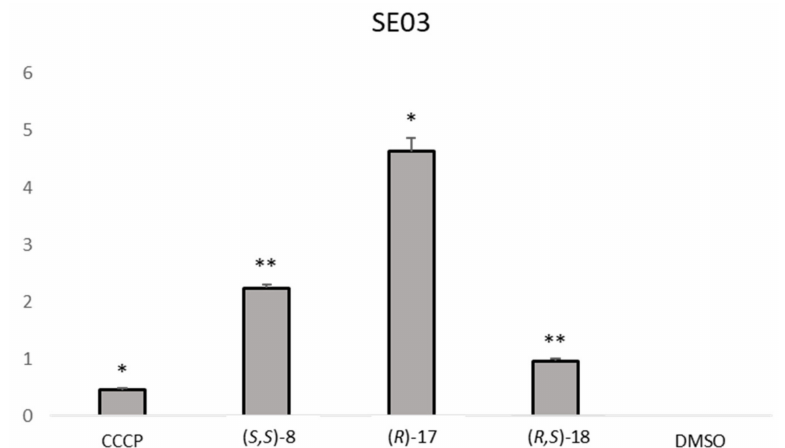
Figure 2. Comparison of the RFI of different compounds to those of the positive controls [ S. aureus 272123 ( top ); SE03 ( bottom )]. Results are presented as mean ± SD. Statistical comparisons were performed using the t -test [* p < 0.05; ** p < 0.01 vs. control (DMSO 1% v/v )].